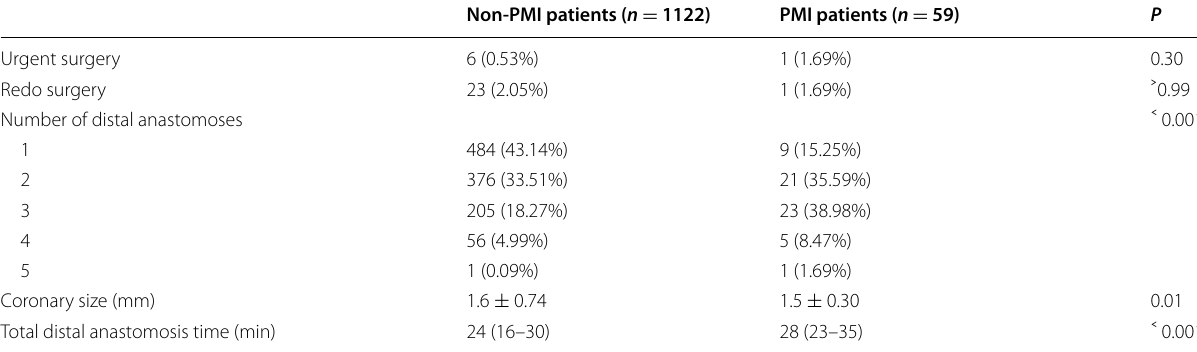
Continuous variables were presented as mean and standard deviation if normally distributed and median (25th–75th percentiles) if not normally distributed. Categorical data were presented as frequencies and percentages PMI perioperative myocardial